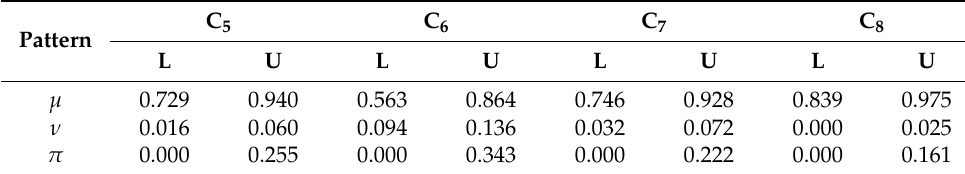
Table 12. Coordinates of the reference object for criteria C 5 –C 8 .